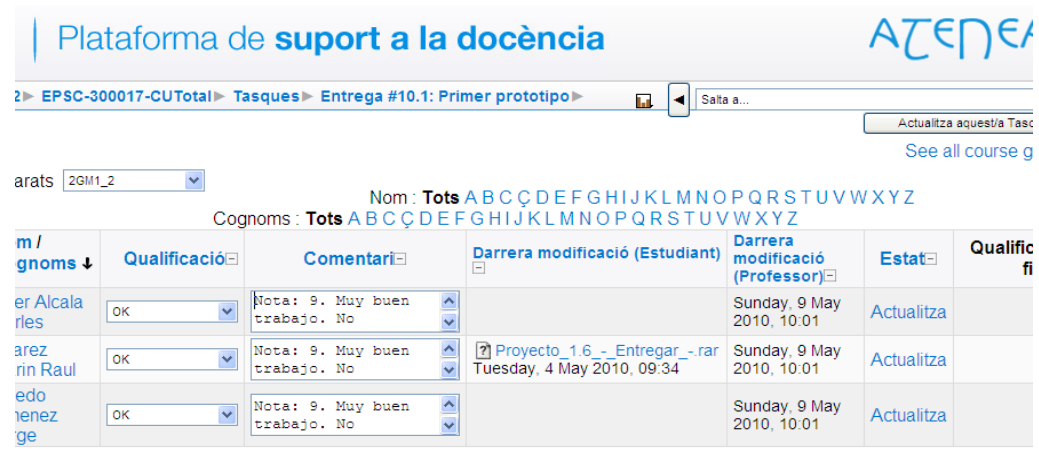
Figure 3: The Campus Virtual facilitates deliverable management and, in particular, it allows professors to make detailed comments in a well-organized manner and it is easily accessible for those students